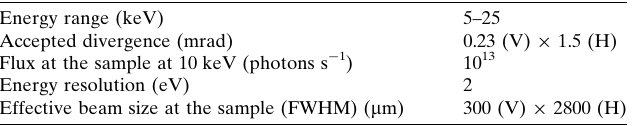
Table 1 The major MS beamline parameters.